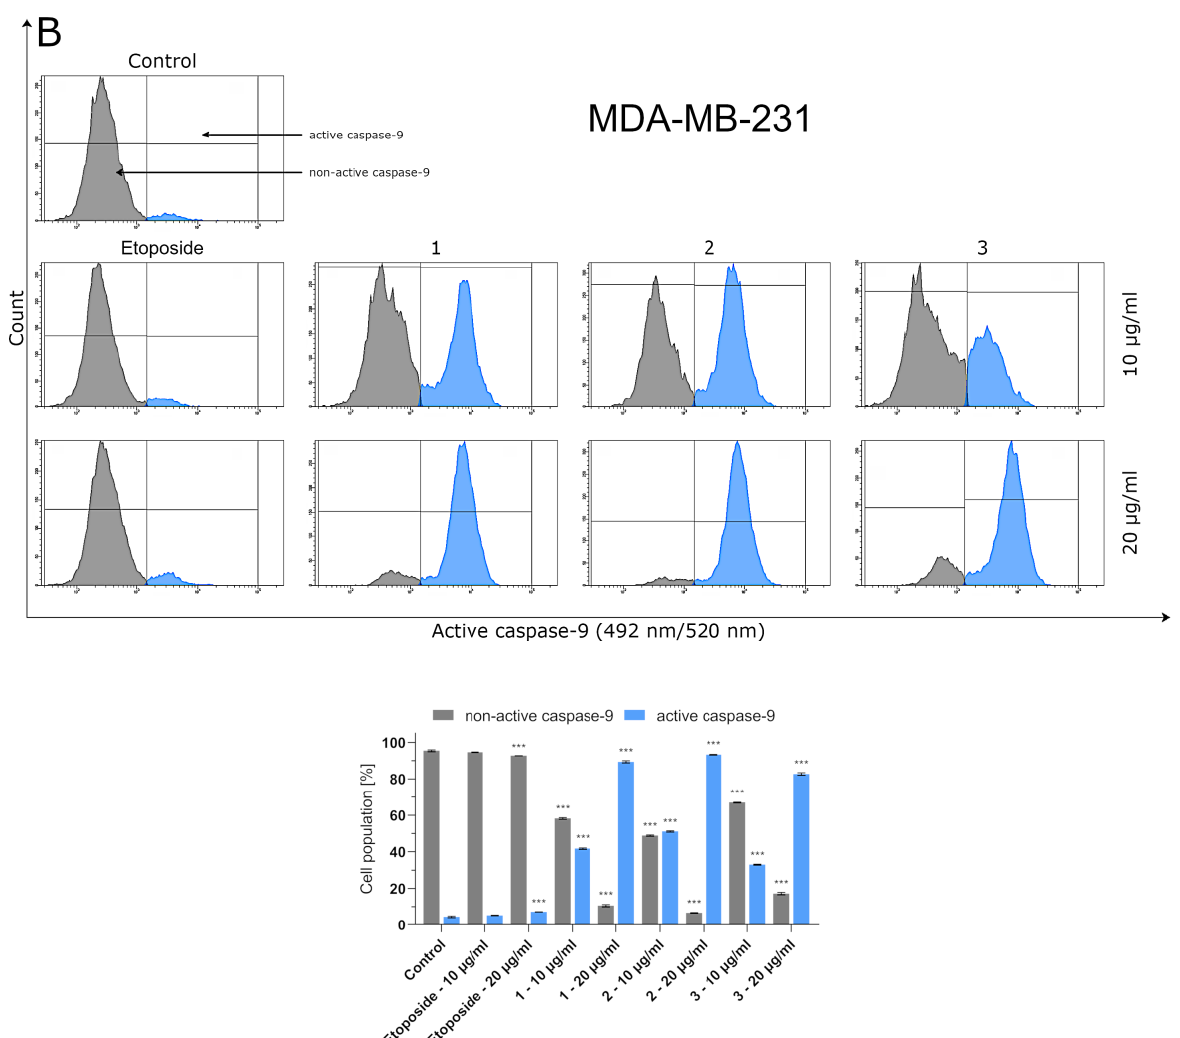
Figure 4. Flow cytometric analyses of MCF-7 ( A ) and MDA-MB-231 ( B ) breast cancer cells treated for 24 h with compounds 1 – 3 and etoposide for active caspase-9. The compounds were tested at the following concentrations: 1 (10 µ g/mL/23.83 µ M and 20 µ g/mL/47.66 µ M), 2 (10 µ g/mL/22.75 µ M and 20 µ g/mL/45.50 µ M), 3 (10 µ g/mL/23.78 µ M and 20 µ g/mL/47.56 µ M) andetoposide (10 µ g/mL/17 µ M and 20 µ g/mL/34 µ M). Mean percentage values from three independent experiments (n = 3) performedin duplicate are presented. ** p < 0.01 vs. control group, *** p < 0.001 vs. control group.